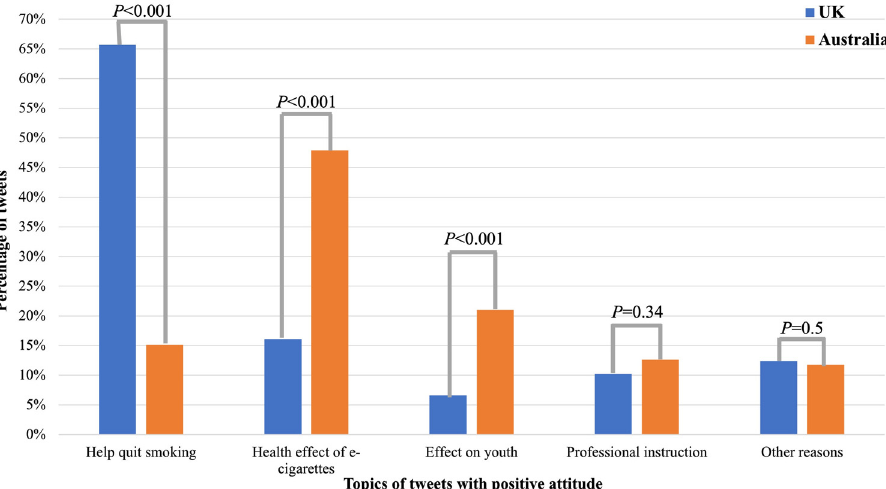
Figure 3. Topics in tweets with positive attitudes towards the e-cigarette prescription policy in the UK and Australia.